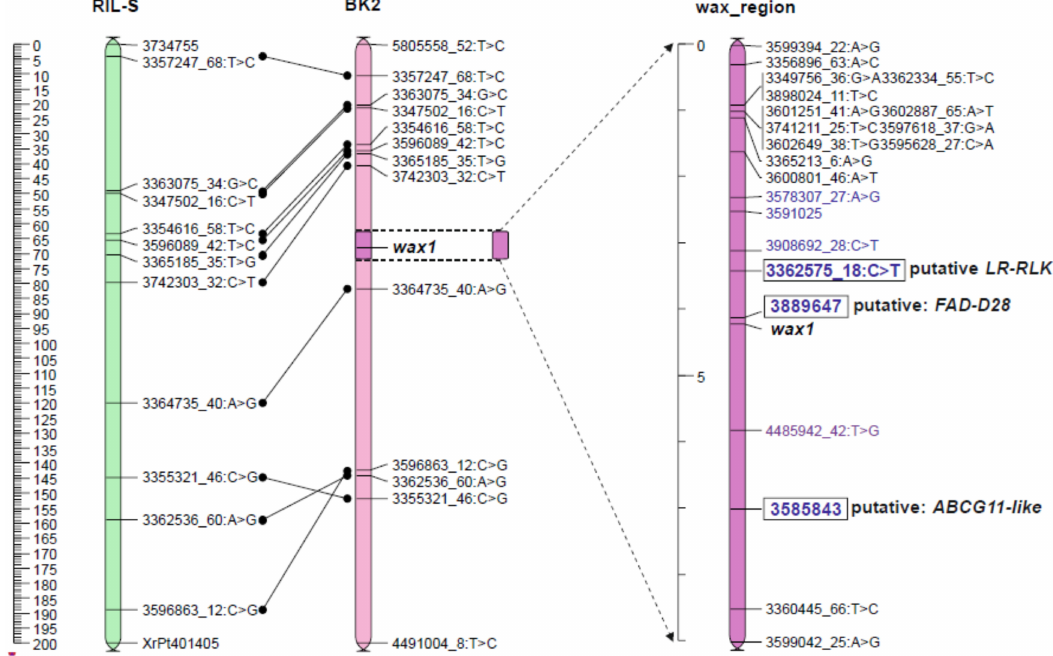
Figure 2. Position of the wax locus on the rye chromosome 2R of the BK2 mapping population with reference to the RIL-S map [56]. DArTseqs indicated in the ML analysis are